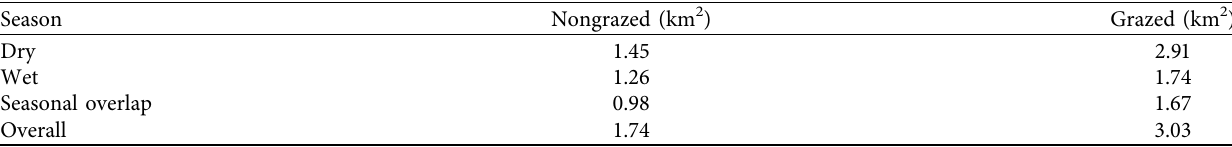
Table 3: Home range of geladas across grazing level and